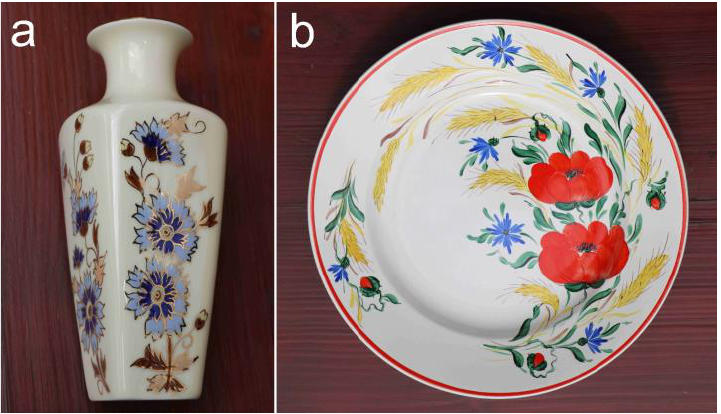
Figure 10. ( a ) Porcelain vase with cornflower motifs (Zsolnay factory); ( b ) Hand-painted wall plate ceramics (Photographs by Gyula Pinke).